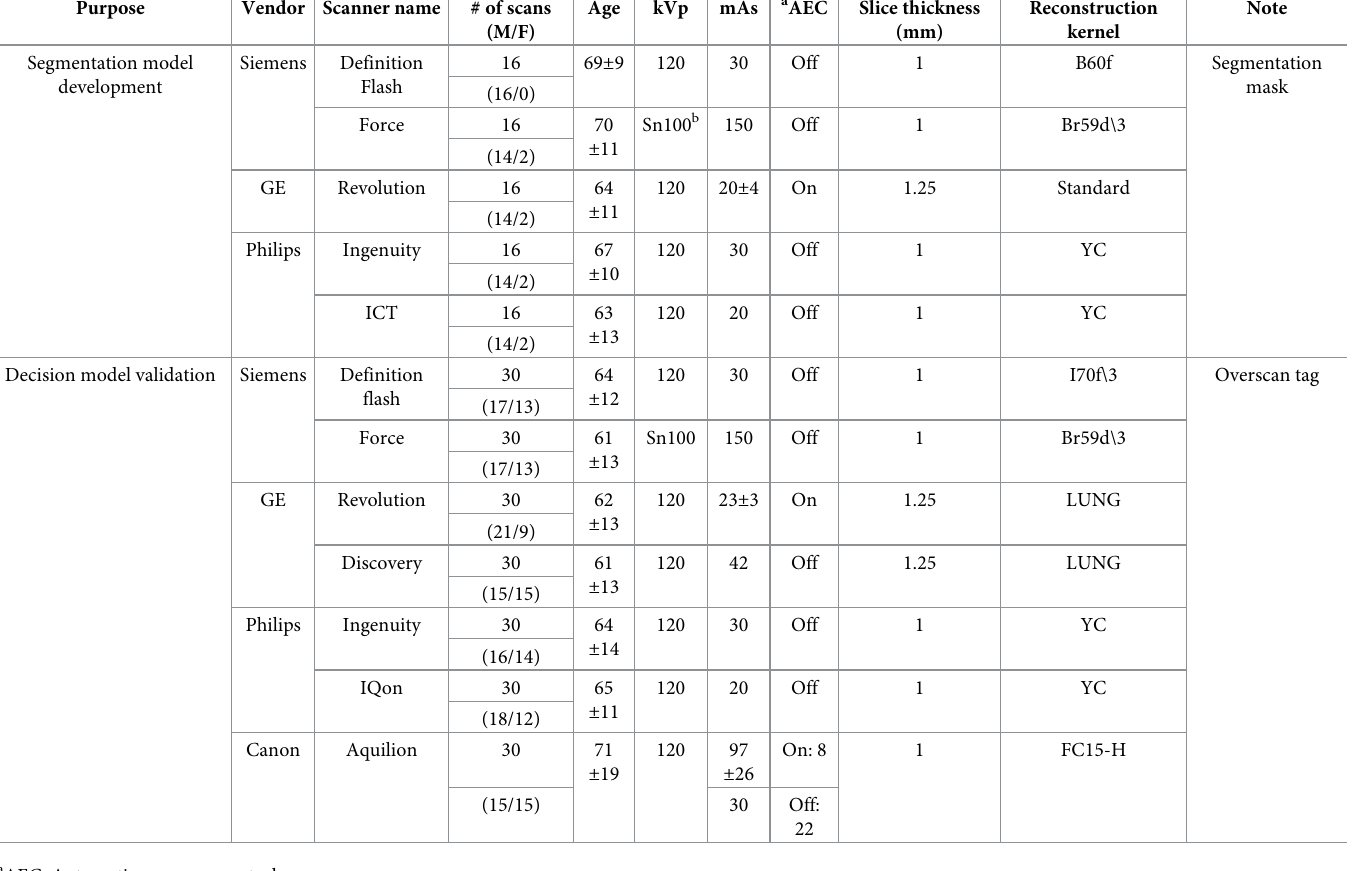
Table 1. Details on internal data. Demographics and scan parameters are presented according to the data usage. Purpose Vendor Scanner